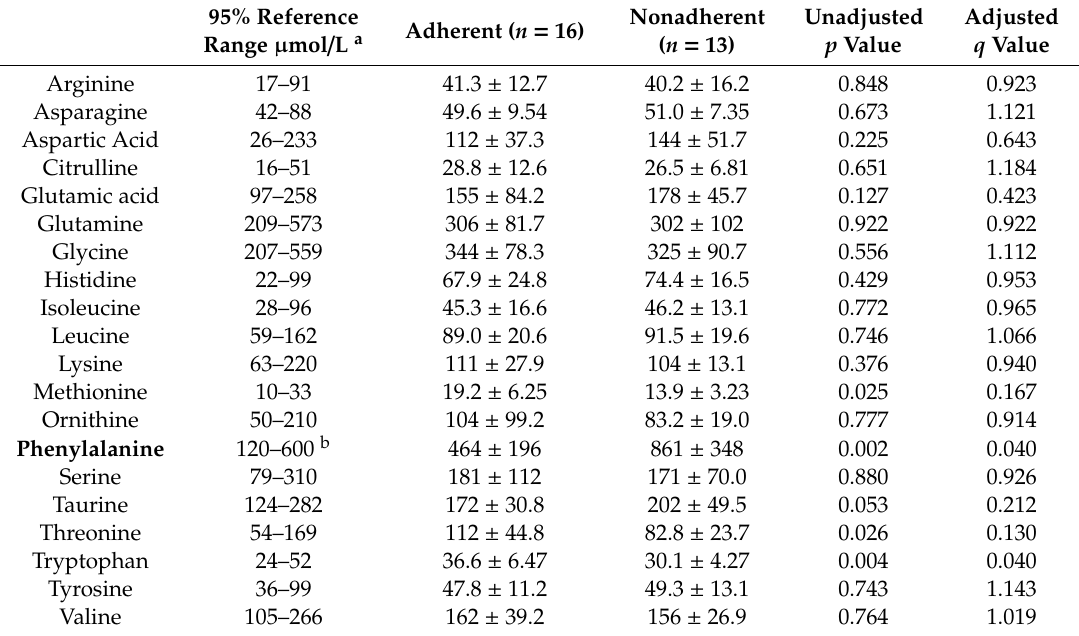
Table 3. Blood Amino Acid Profile in Adherent and Nonadherent